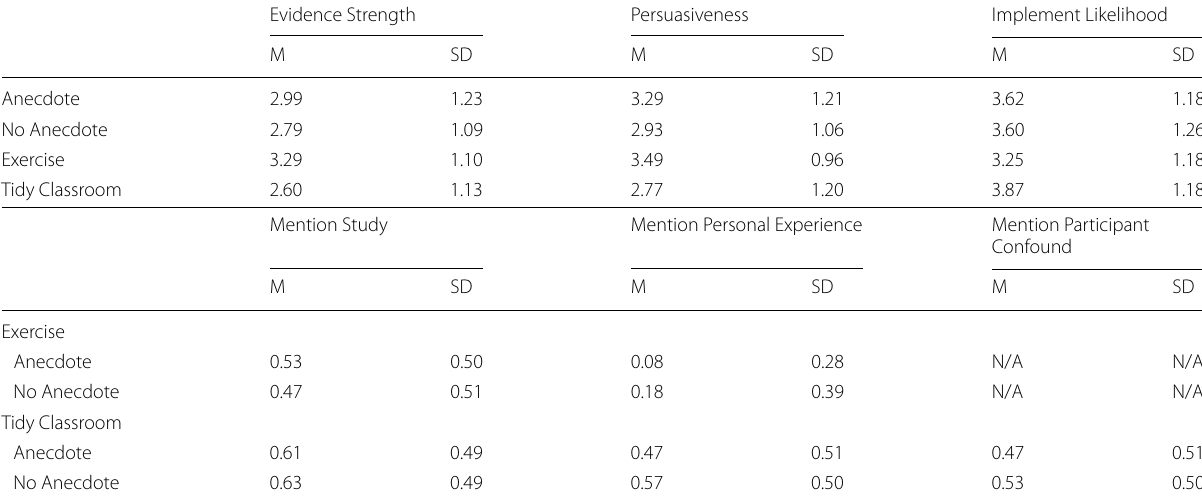
Table 1 Descriptive statistics for article ratings and open-ended responses in Experiment